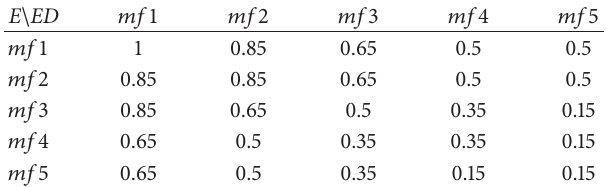
Table 1: Rules for 𝐾 𝑝 .